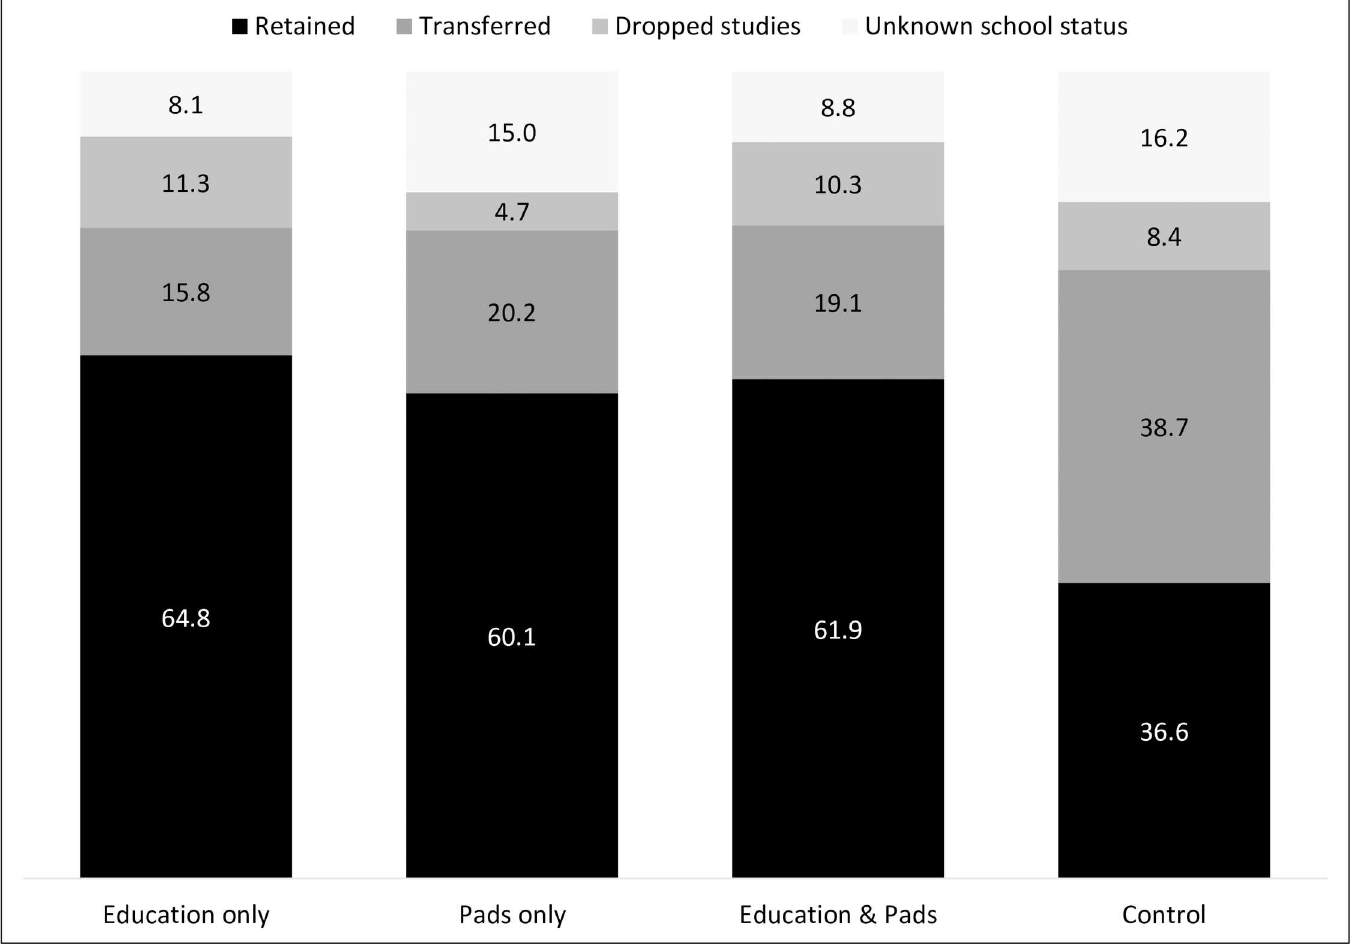
Fig 2. School status at follow-up according to condition (%) (n =